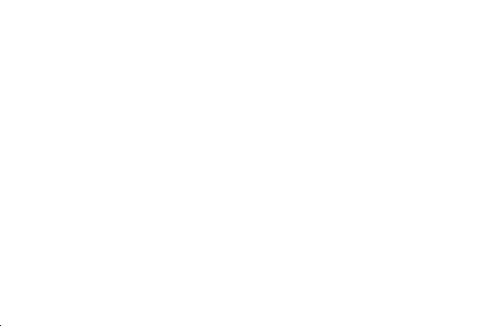
Table 2. Characteristics of the study base at